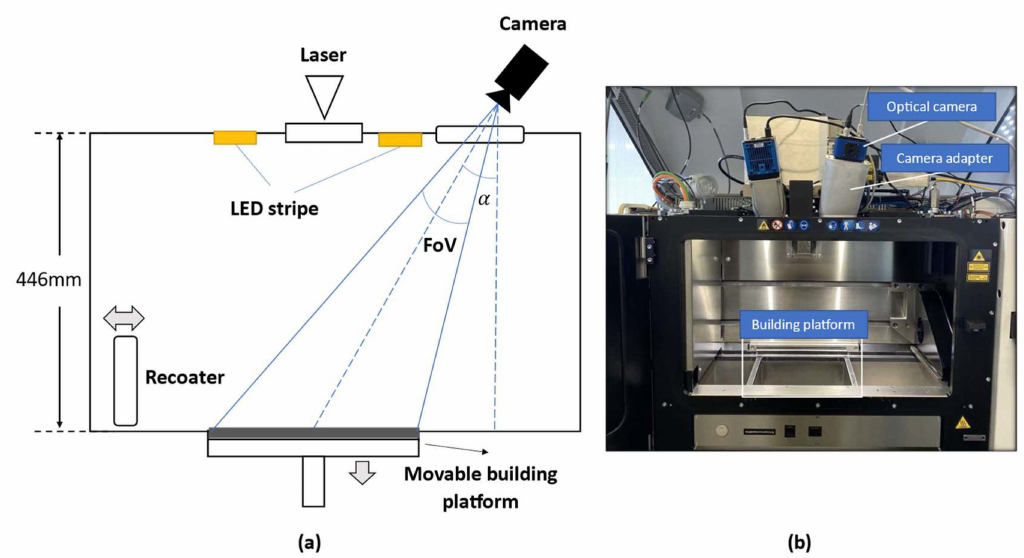
Figure 1. ( a ) Illustration of in situ monitoring system integration; ( b ) Experiment